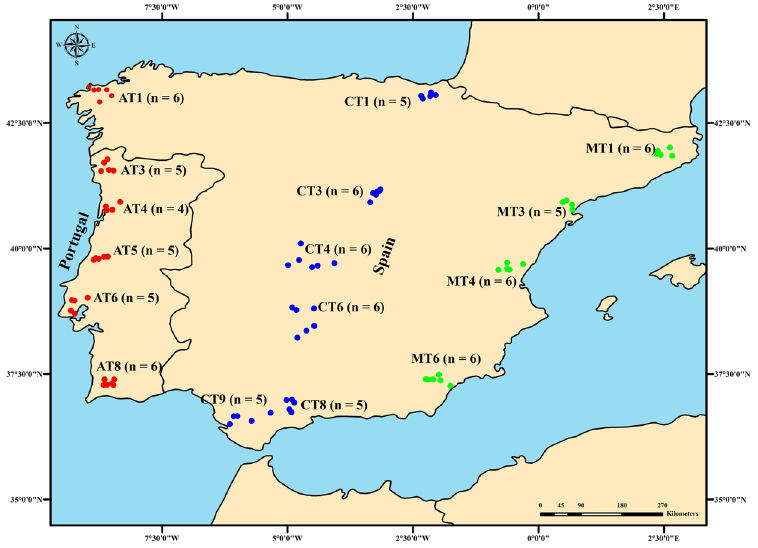
Figure 1. Location of sampling sites. The samples were distributed across three transects in the Iberian Peninsula, represented by three different colours: Atlantic in red (AT; N = 31), Central in blue (CT; N = 33), and Mediterranean in green (MT, N = 23). Each dot represents a single colony and apiary. Sampling site codes (AT1 to MT6) correspond to those reported by Chávez-Galarza, et al . 41